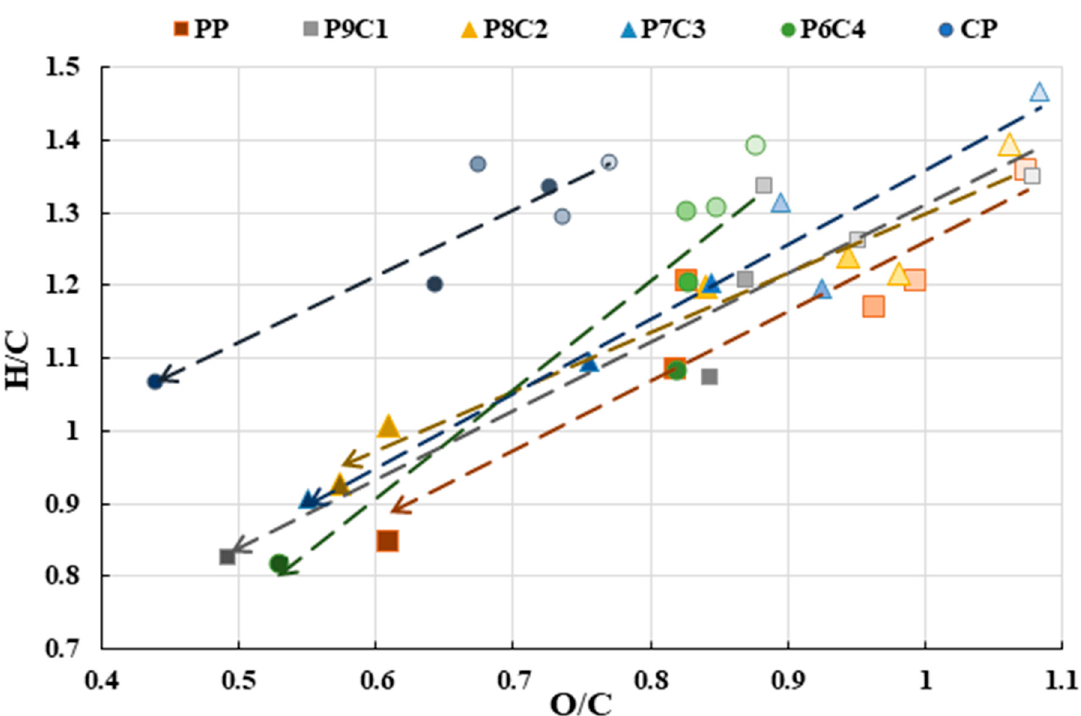
Figure 5. Torrefaction-induced changes in H/C and O/C for each pellet.